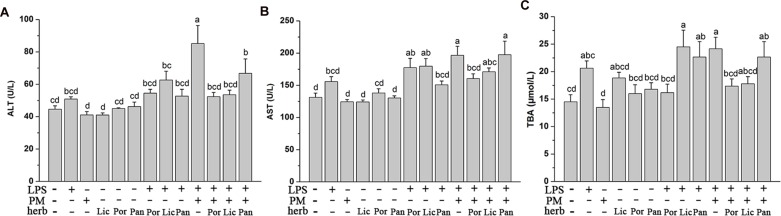
The Plasma biochemical indicators in the absence and presence of LPS with PM and herbs including Poria (Por), Licorice (Lic), Panax notoginseng (Pan). Rats were firstly treated with various herbs. After three hours, groups with LPS received 2.8 mg/kg LPS at caudal vein. (A,B) Blood samples were taken at 7 h after the administration of LPS, and plasma ALT and AST levels were measured. (C) Plasma TBA content were measured in the same conditions. The results were expressed as mean ± SEM (n = 9). Mean values followed by the same letter are not significantly different (P < 0.05) as determined by Duncan’s multiple-range test.